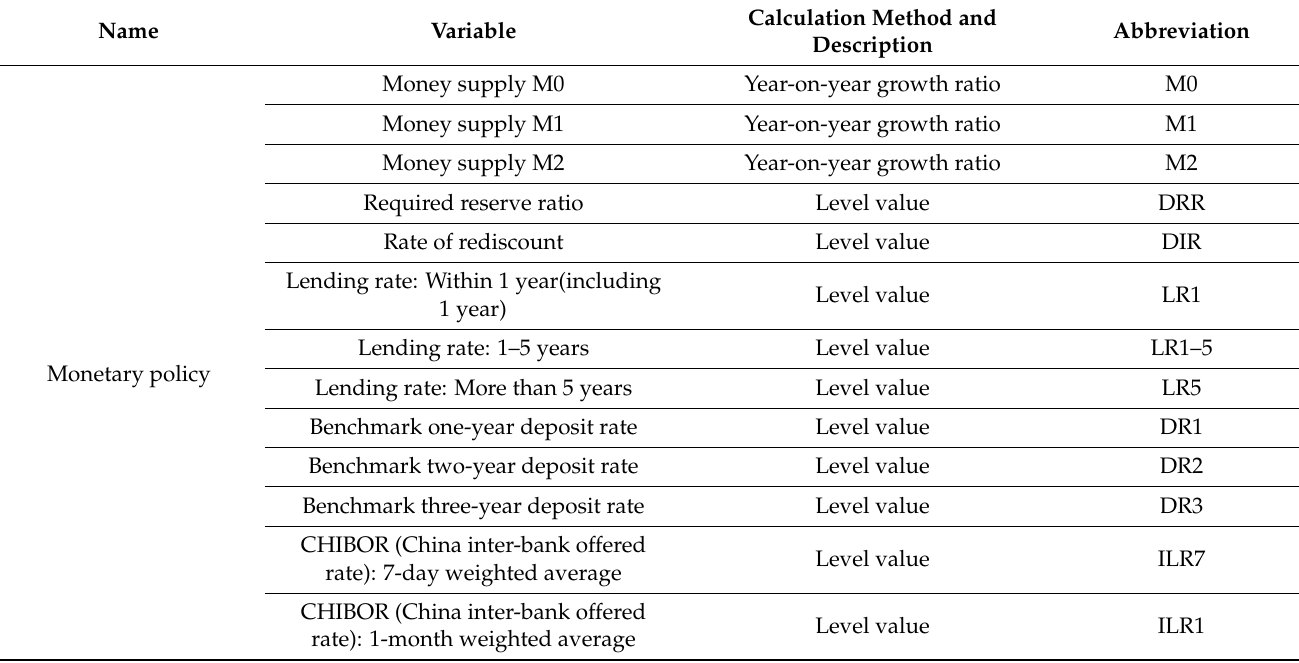
Table A1. Explanation of variables used in constructing China’s monetary policy uncertainty